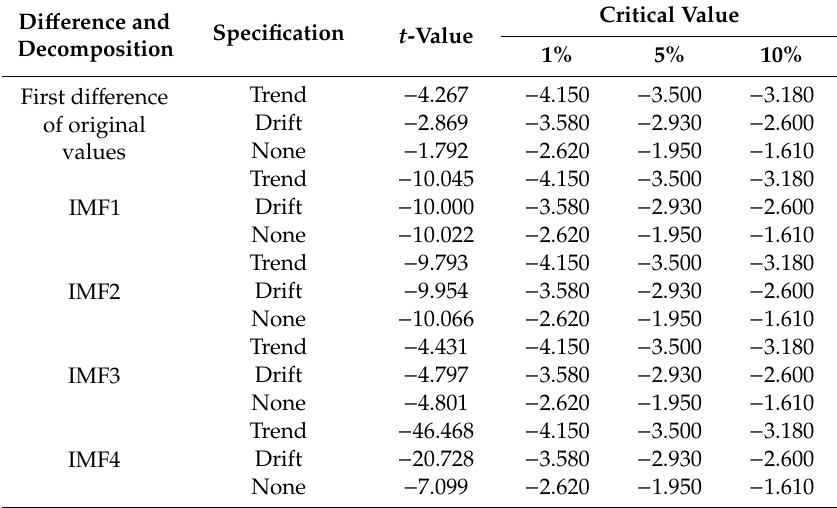
Table 1. Stationary analysis of primary energy consumption in